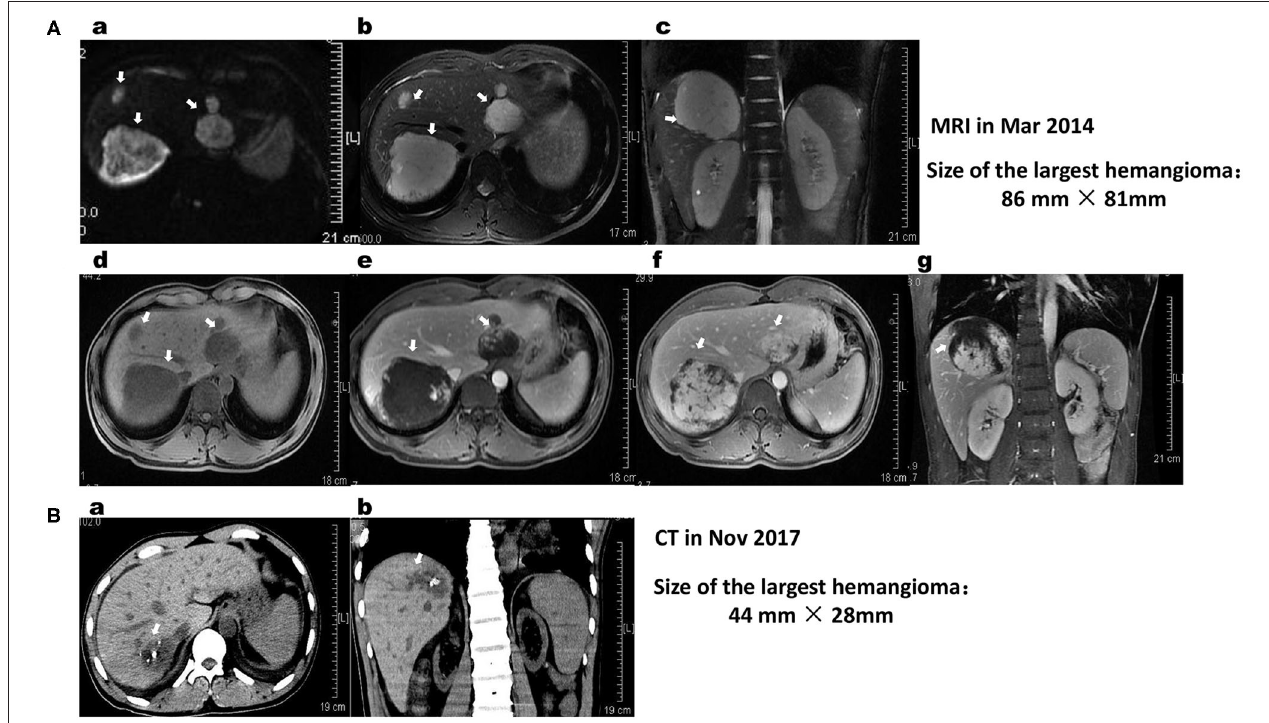
FIGURE 1 | (A) MRI of the liver shows lobulated lesions in the subcapsular aspect of segments 2, 7, and 8 of the liver (white arrows). The largest lesion is located at segment 7, its size is ∼ 86 × 81 × 81mm, and it is closely related to the liver segments of the right hepatic vein and IVC. The size of the lesion in S2 is ∼ 54 × 44 × 41mm. The hemangiomas on MRI appear hyperintense on DWI (a) and T2WI (b,c) and hypointense on T1WI (d–g) sequences. On post-contrast dynamic imaging, the lesion demonstrates discontinuous peripheral nodular enhancement on the arterial phase (e) with incomplete centripetal fill-in on the delayed phase (d,f). The findings are consistent with hepatic hemangiomas. (B) Comparing the cross-sectional CT (a) and coronal (b) reformatted CT images with those of MRI images on March 16, 2014, primary multiple hemangiomas in the liver were significantly shrunk, and their boundaries were not clear. The size of the giant hemangioma in segment 7 of the liver was decreased to 44 × 28mm, with unclear borders and nodular high-density shadows inside it. The lesions are closely related to the liver segments of the right hepatic vein and